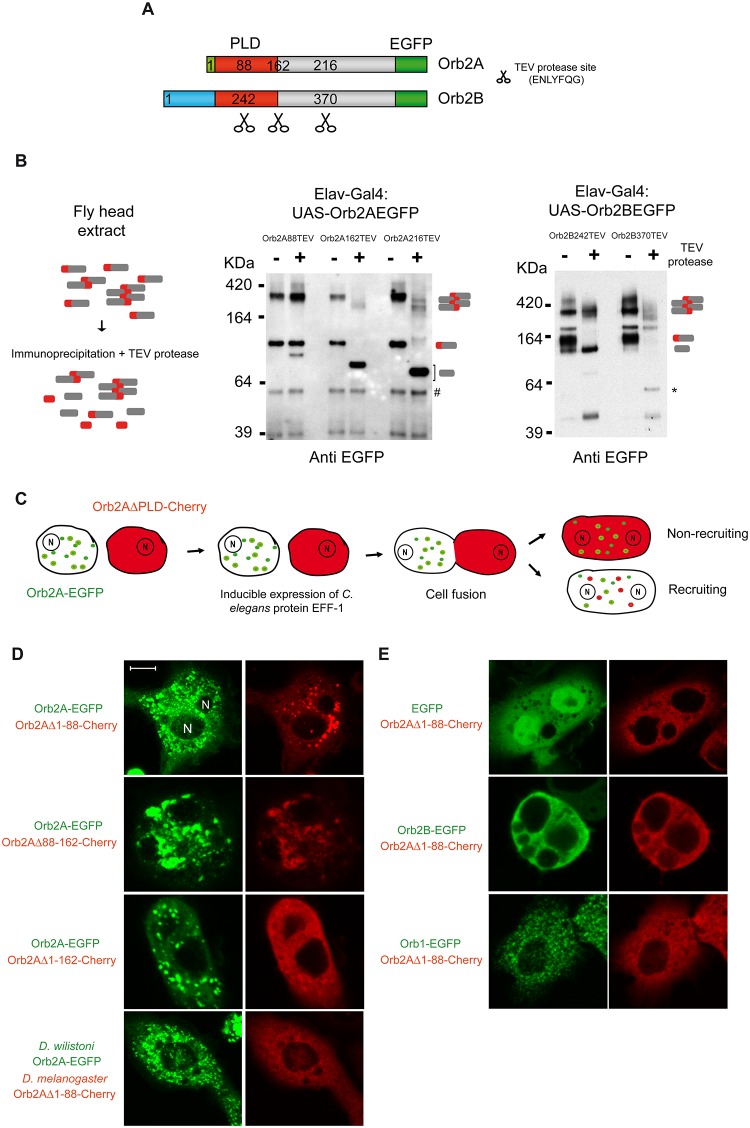
Organization of the Orb2 PLD.(A). Schematic representation of the location of the TEV protease recognition motif (ENLYFQG) inserted into Orb2. (B) EGFP-tagged Orb2A and Orb2B bearing TEV protease sites were expressed pan-neuronally, and immunopurified Orb2 was treated with TEV protease for 24 h. The left panel shows the schematic of the experiment. The cleaved C-terminus of different sizes derived from Orb2A are indicated with a bracket. The * indicates an EGFP reactive polypeptide most likely originated from degradation of the cleaved Orb2B370TEV C-terminus. (C) Schematic diagram of the epithelial fusion failure 1 (EFF-1) cell fusion “cytoduction” experiment in S2 cells. The expected outcomes in terms of the recruitment or nonrecruitment of oligomers are indicated. (D) Residues 88 to 162 are sufficient for recruitment into pre-existing oligomers. Full-length Orb2A-EGFP induced the Orb2A construct lacking the 88 N-terminal residues (Orb2AΔ1-88-Cherry) to oligomerize. Full-length Orb2A from D. willistoni failed to induce oligomerization of Orb2AΔ1-88-Cherry. (E) EGFP, Orb2B-EGFP, or Orb1-EGFP also failed to induce oligomerization of Orb2AΔ1-88-Cherry. Representative examples of fused cells are shown and the n for each experimental set is ≥10. Scale bar = 5 μm.